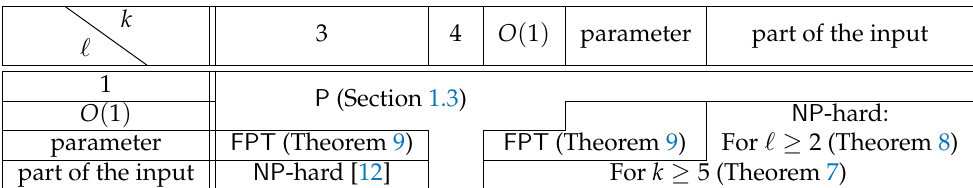
Table 3. Summary of the results for S ORTING BY M ULTI -C UT R EARRANGEMENTS in permutations. Additionally, O PT -SMCR admits a 2-approximation algorithm (Theorem